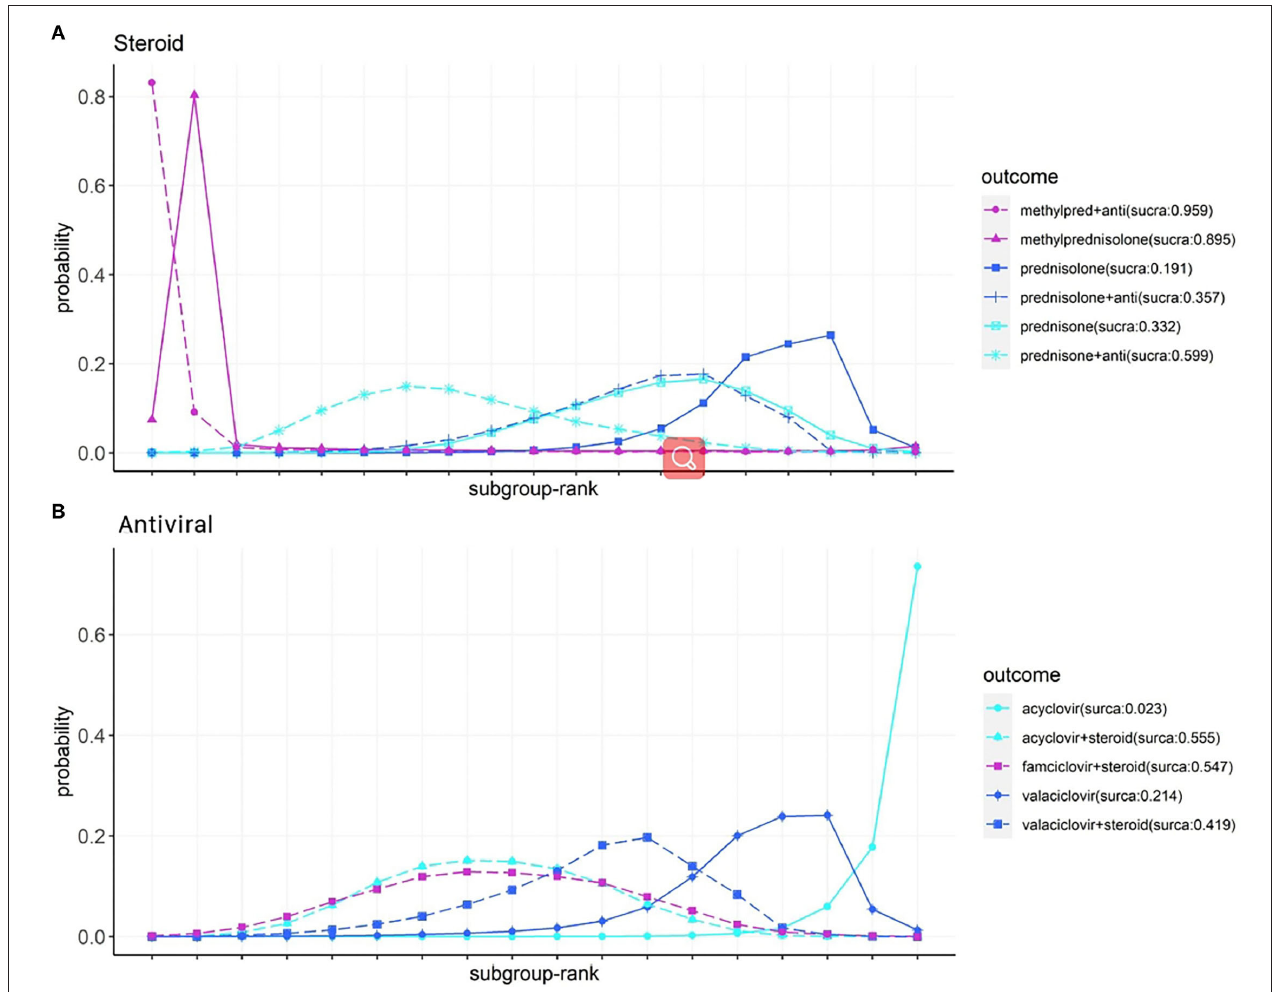
FIGURE 5 | Subgroup analysis of steroids (A) and antivirals (B) on facial recovery for patients with Bell’s palsy, according to Bayesian ranking profiles. Profiles indicate the probability of each comparable treatment being ranked from first to last on facial recovery (Anti, antiviral; methyl pred,